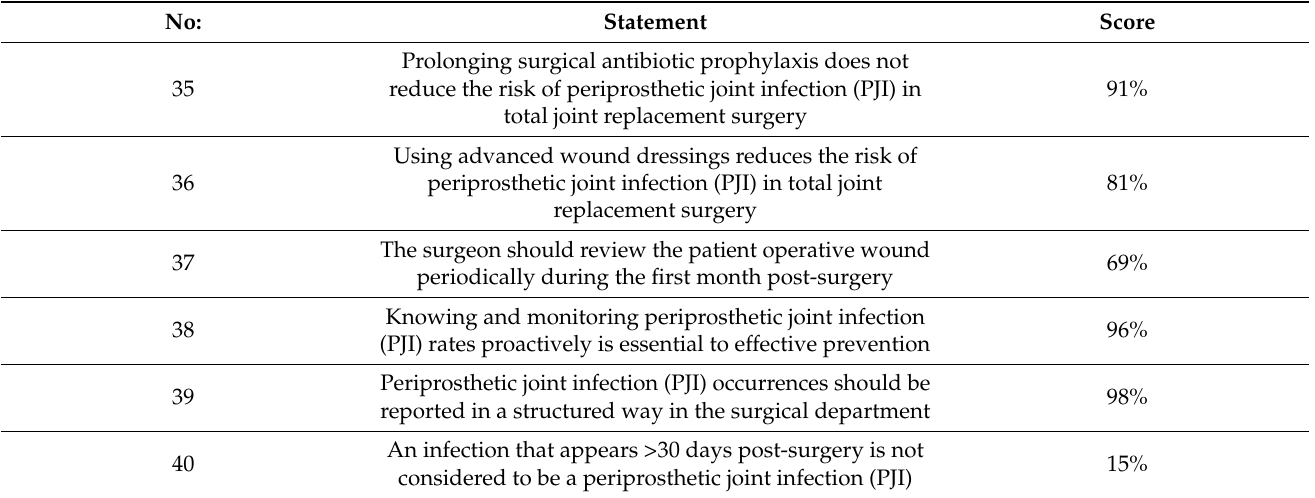
Table 5. Consensus statements and agreement scores on Domain E: what other post-operative action could be implemented to improve the prevention of